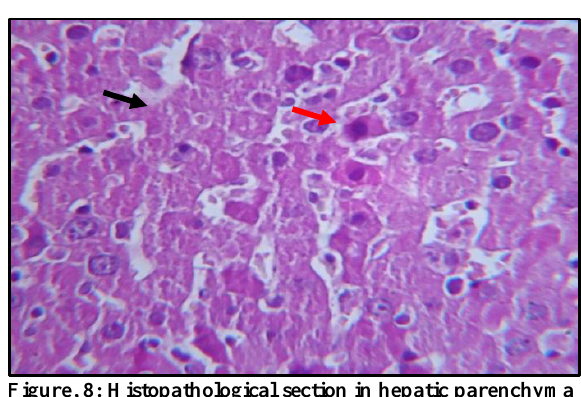
Figure, 8: Histopathological section in hepatic parenchyma shows coagulative necrosis ( ) and apoptosis ( ) (H and E x400).